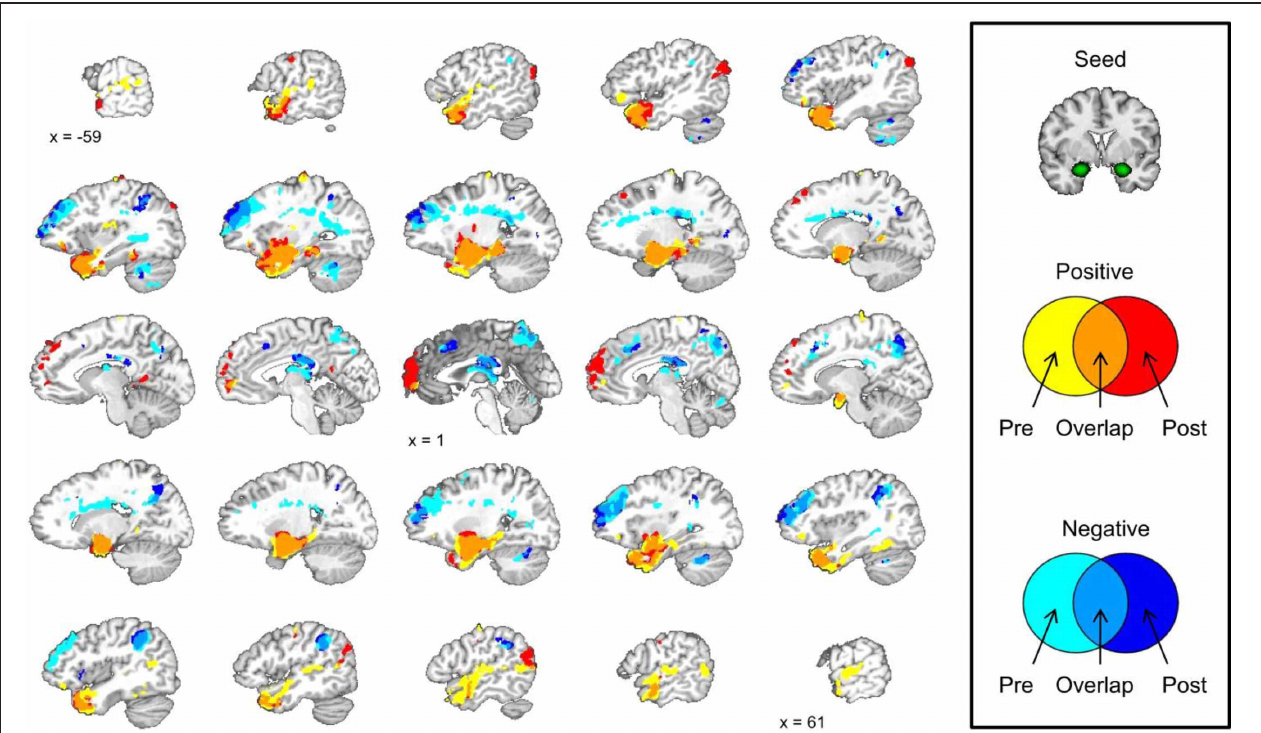
FIGURE 4 | Amygdala functional connectivity before and after the conditioning task shows some similarities and some differences. Brain images depict the pre- and post-conditioning connectivity maps as well as where those maps overlap.